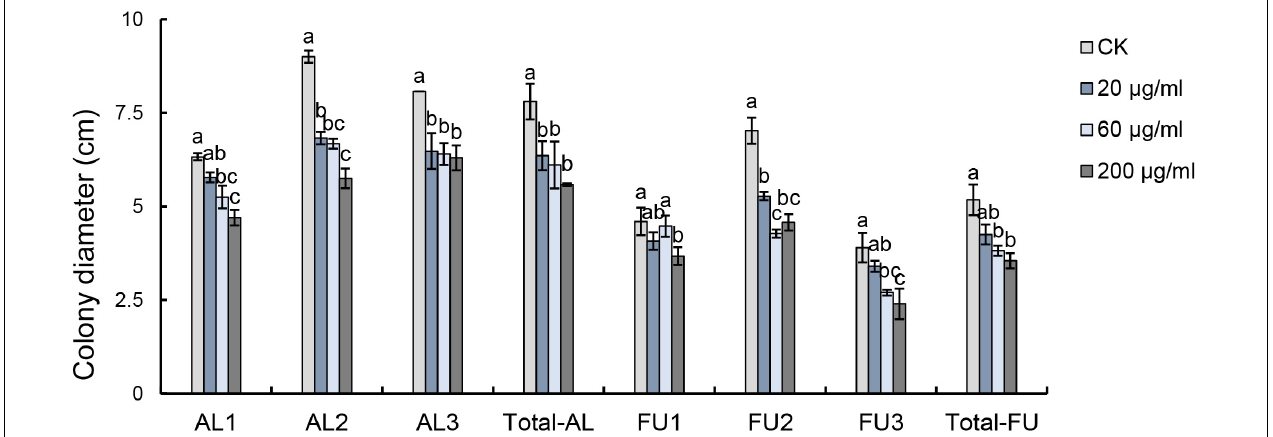
FIGURE 6 | Effects of harmaline on Alternaria sp. and Fusarium sp. examined by ANOVA ( p < 0.05) and analyzed using Fisher’s LSD test at the p < 0.05 level. Each value is the mean of 4 (for AL1-3, FU1-3) or 12 (for Total-AL, Total-FU) replicates ± SE. Means with different letters indicate significant differences at the p < 0.05 level according to Fisher’s LSD